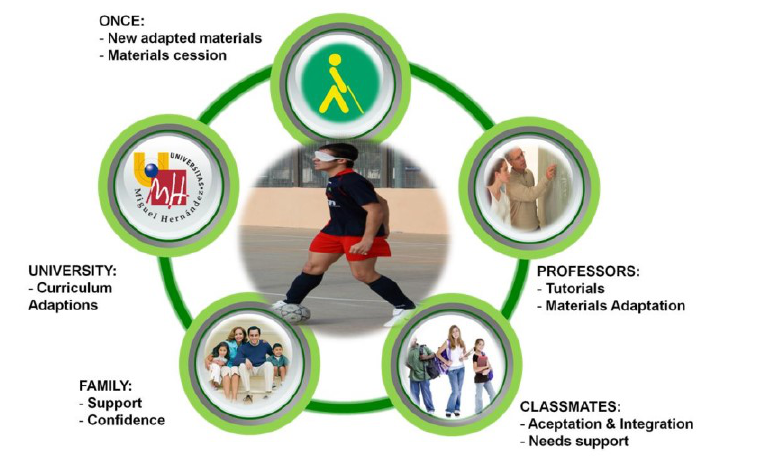
Figure 1. Stakeholders that took part in the inclusion process and their main